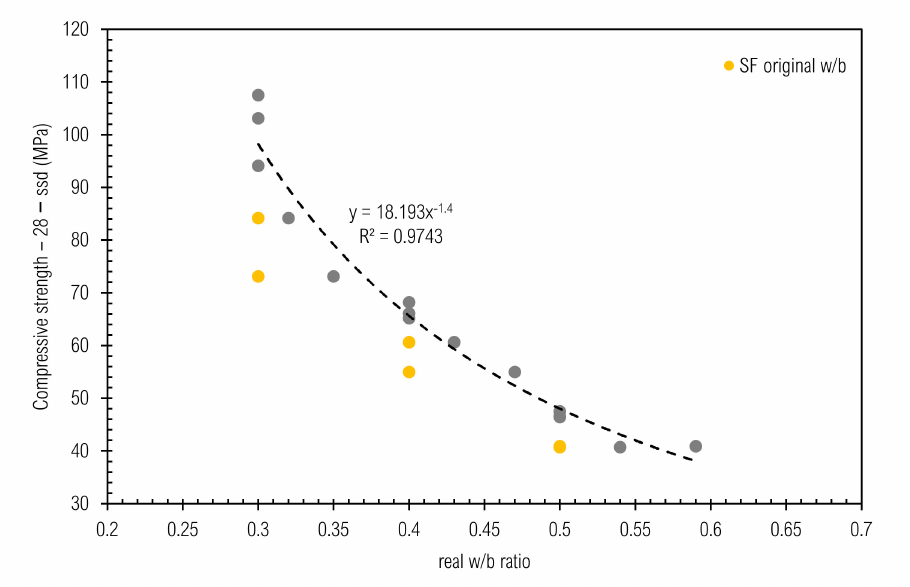
Figure 11. Relation between f c − 28 − ssd and real w/b